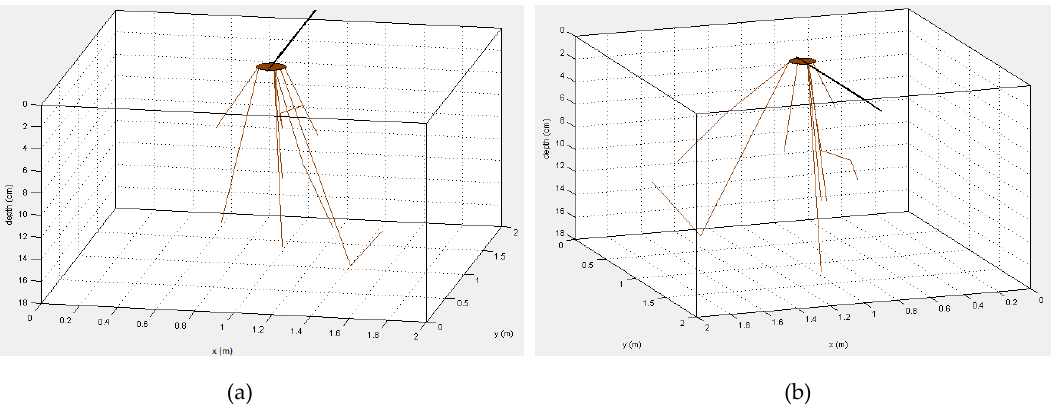
Figure 10. Tree root field experiment X: ( a ) Front view of the 3D root morphology map. ( b ) Back view of the 3D root morphology map. The black line represents the start/end line; the brown lines represent the roots created by the TreeWin Roots software program; and, the pink lines represent markers in the field to calibrate distances during data collection. Table 10. Accuracy, precision, and recall of experiment X for roots more than 1 cm in diameter. Frequency